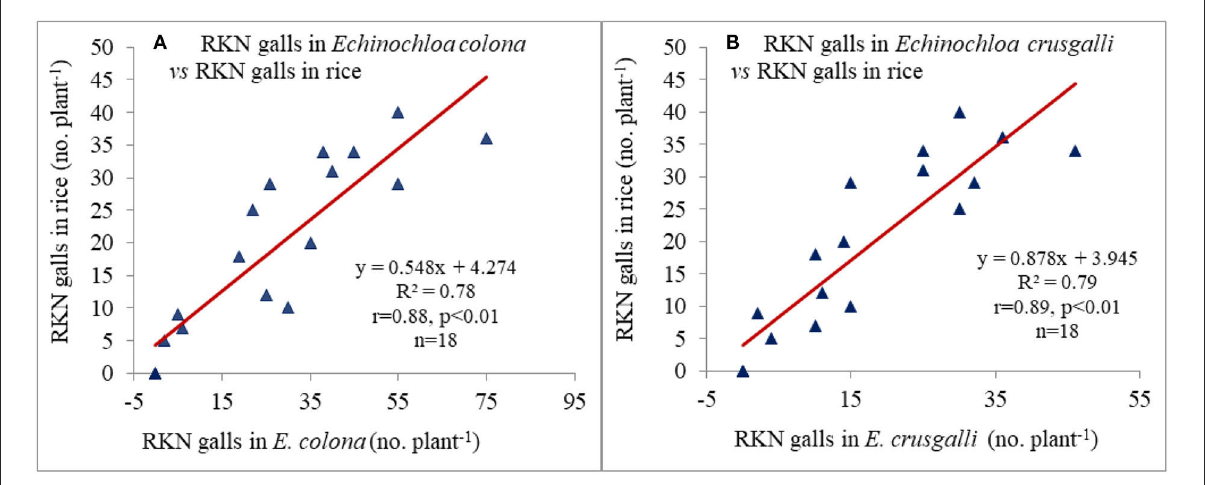
FIGURE2 Relationship between root-knot nematode (RKN) galls in (A) Echinochloa colona and (B) Echinochloa crusgalli with RKN galls in rice (mean of 2 years).